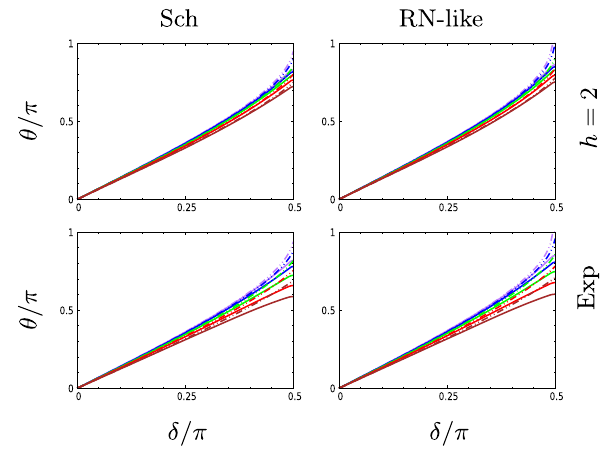
Fig. 31 θ as a function of δ . q ∗ = − ( 0 . 50 M ) 2 , R = 4 M . The purple, blue, green, red and brown lines correspond respectively to (cid:11) = 0 . 1, 0 . 2, 0 . 3, 0 . 4 and 0 . 5. The continuous lines were obtained by numer- ical integration from Eq. (4.8) while the dashed lines were obtained analytically from Eq. (5.2) (with plasma correction)